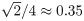
Sloppy rulers without Sloppy Algorithm.(A), length estimate (Q(L, s)) when s is fixed to 0 (light green), 0.1, 0.2, magic number (red), 0.4, 0.5, 0.7 (blue), 1 (magenta), and 2. Perfect fit falls on the diagonal line (circles). (B), performance P(s) given by Eq (8). Maximum occurs at the magic number 2/4≈0.35 (red circle).